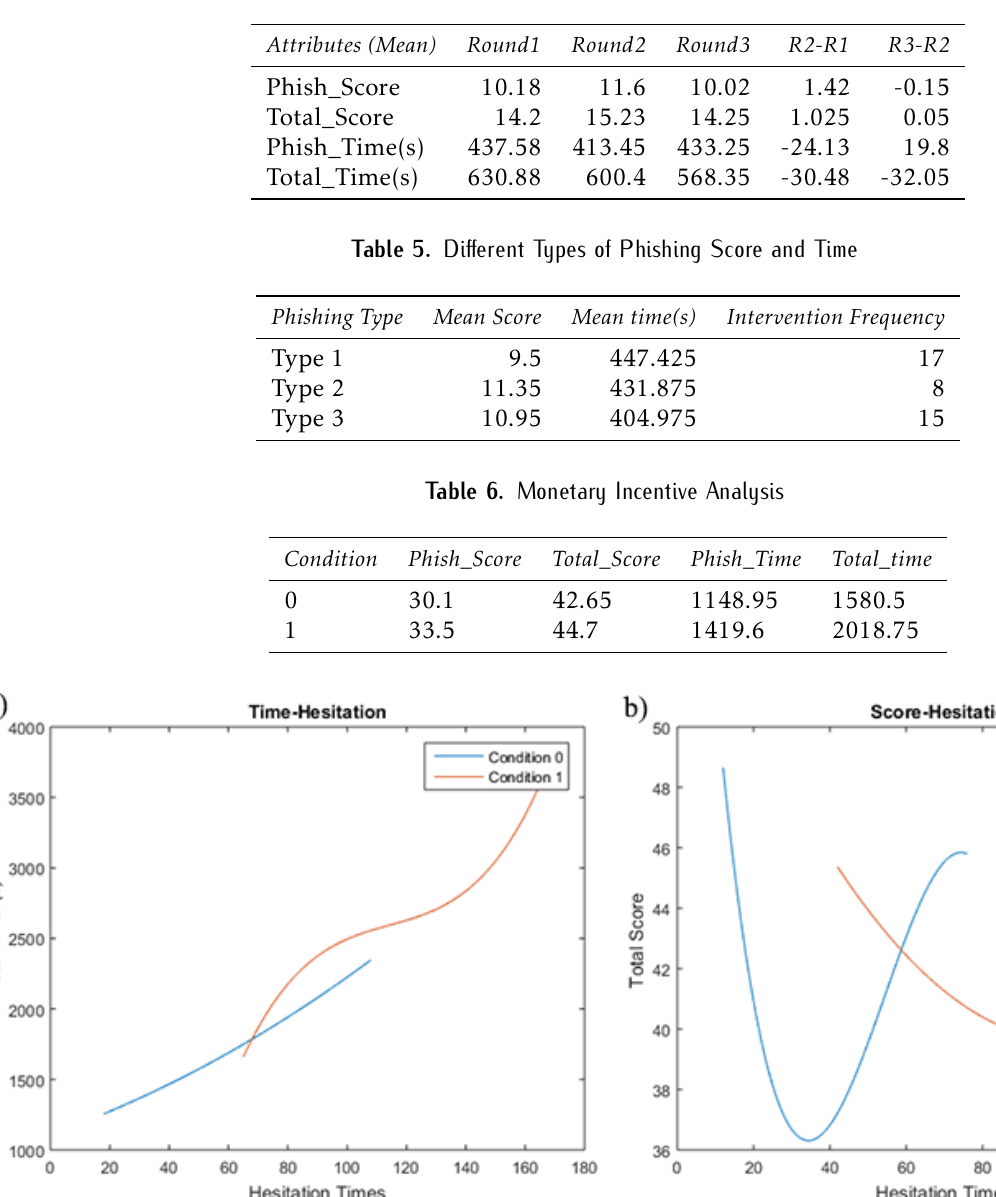
Figure 4. (a) Relationship between hesitation and total time. (b) relationship between hesitation and performance